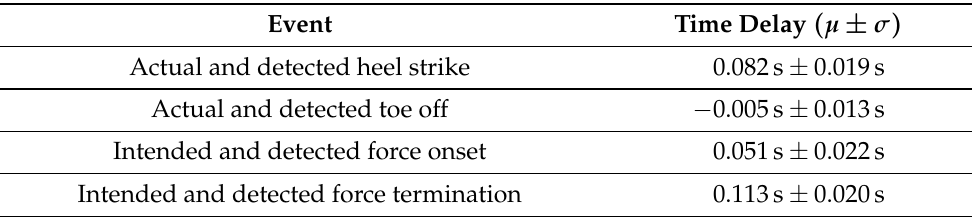
Table 4. Time delays between corresponding events in the hardware verification test.